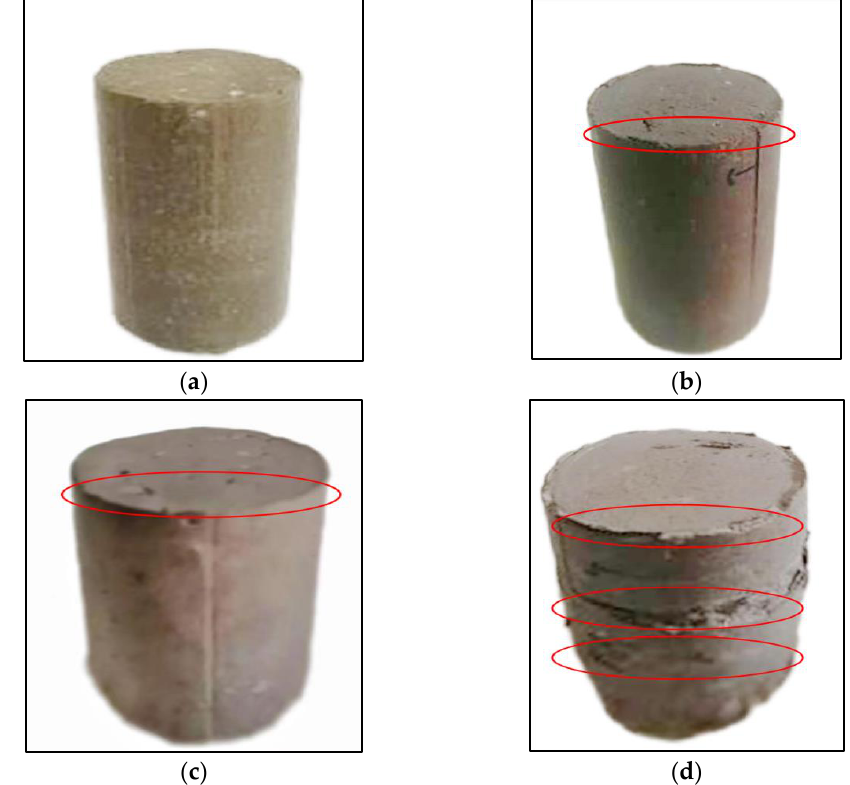
Figure 27. Morphology of the solidified waste silt before and after dry-wet cycles when w g = 10%: ( a ) N dw = 0, ( b ) N dw = 1, ( c ) N dw = 3, ( d ) N dw = 6.